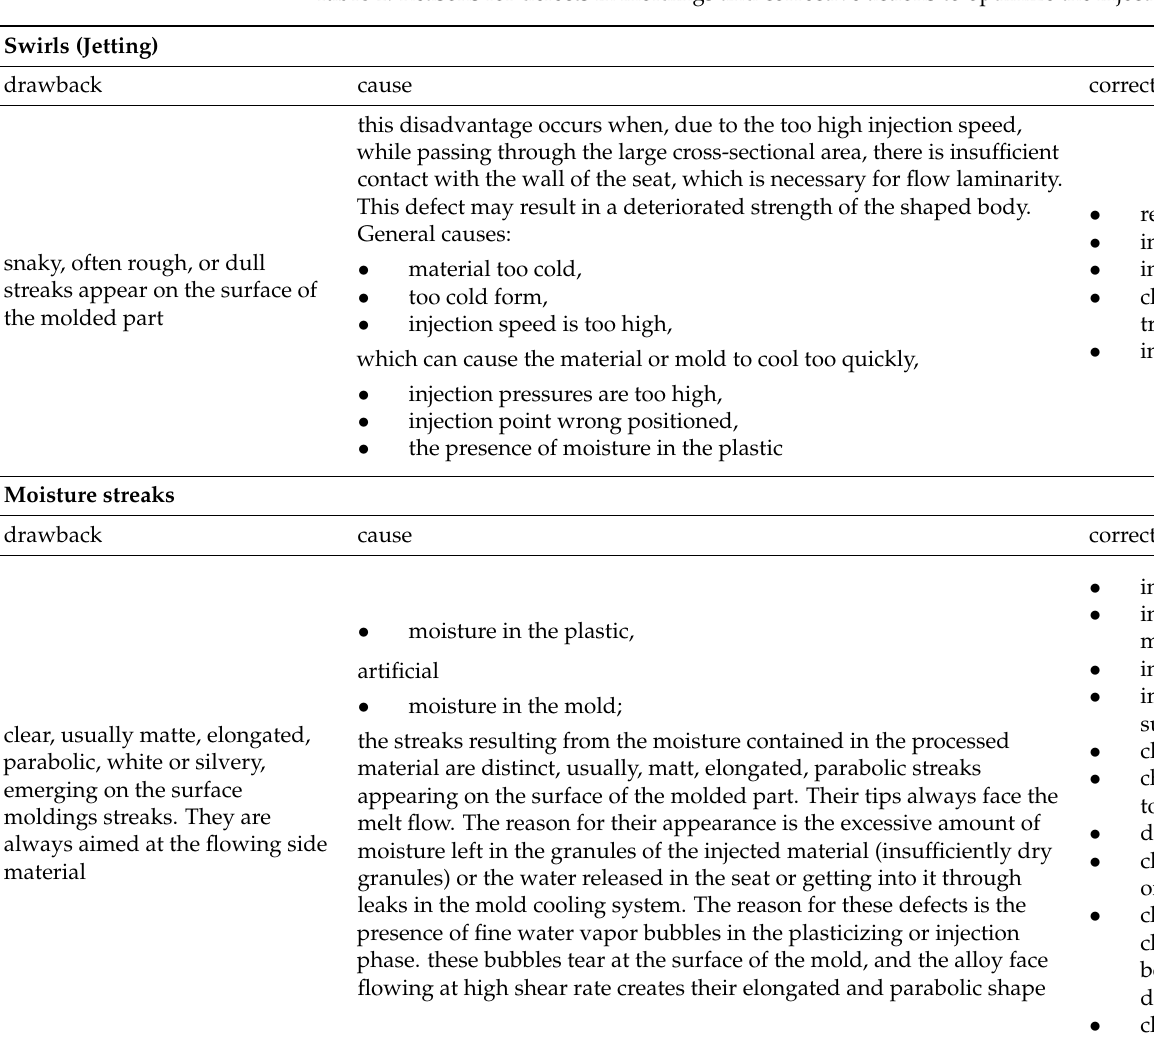
Table 1. Reasons for defects in moldings and corrective actions to optimize the injection